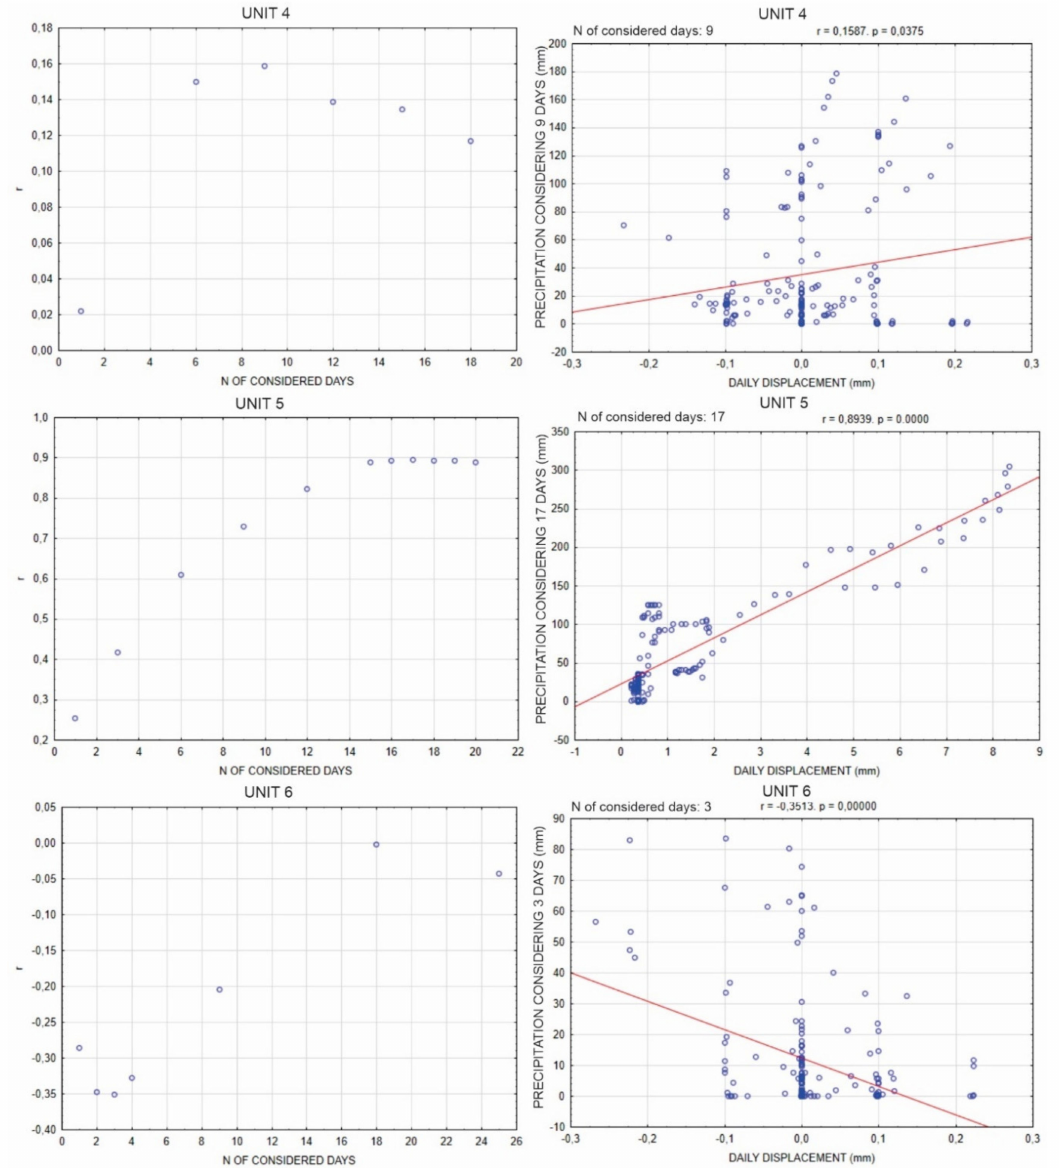
Figure 17. Determination of the highest correlation (r) between daily displacement and the number of days considered for antecedent precipitation (left), and correlation between daily displacement and established best-correlated number of antecedent precipitations for units